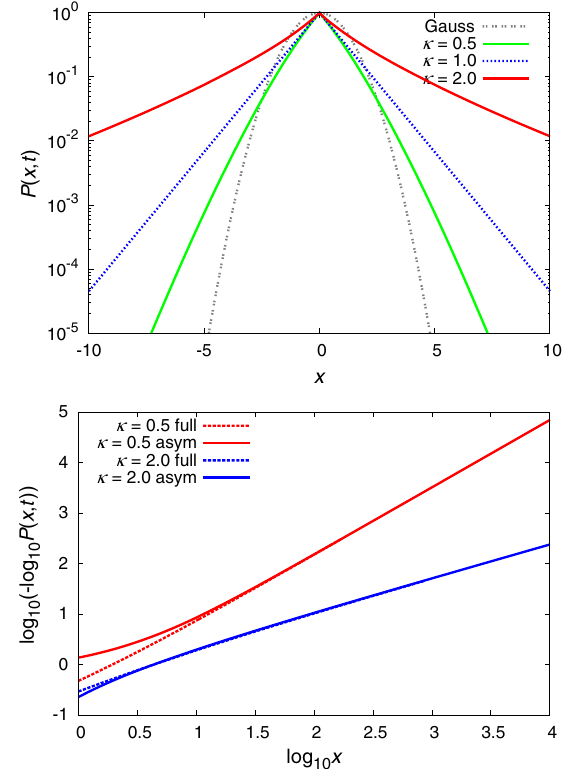
FIG. 6. Top panel: Superstatistical probability density function P x; t Þ according to Eq. (A3) from numerical integration, for s ð exponents κ ¼ 0 . 5 , 1, and 2 (see the figure key). Bottom panel: Convergence of the full numerical solution to the analytical asymptotic form (A8) for κ ¼ 0 . 5 and 2. All distributions are drawn for t ¼ 1